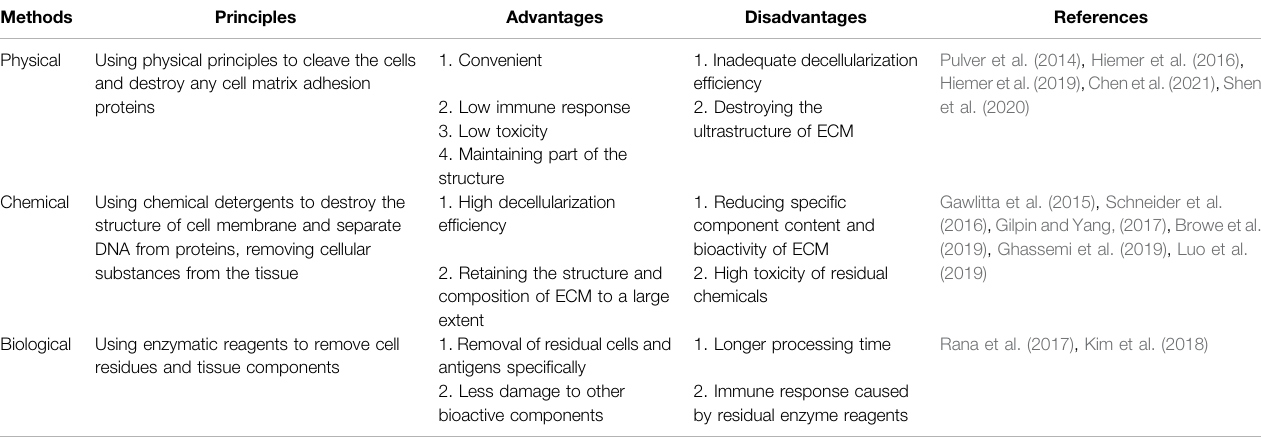
TABLE 2 | Characteristics of different AC decellularization